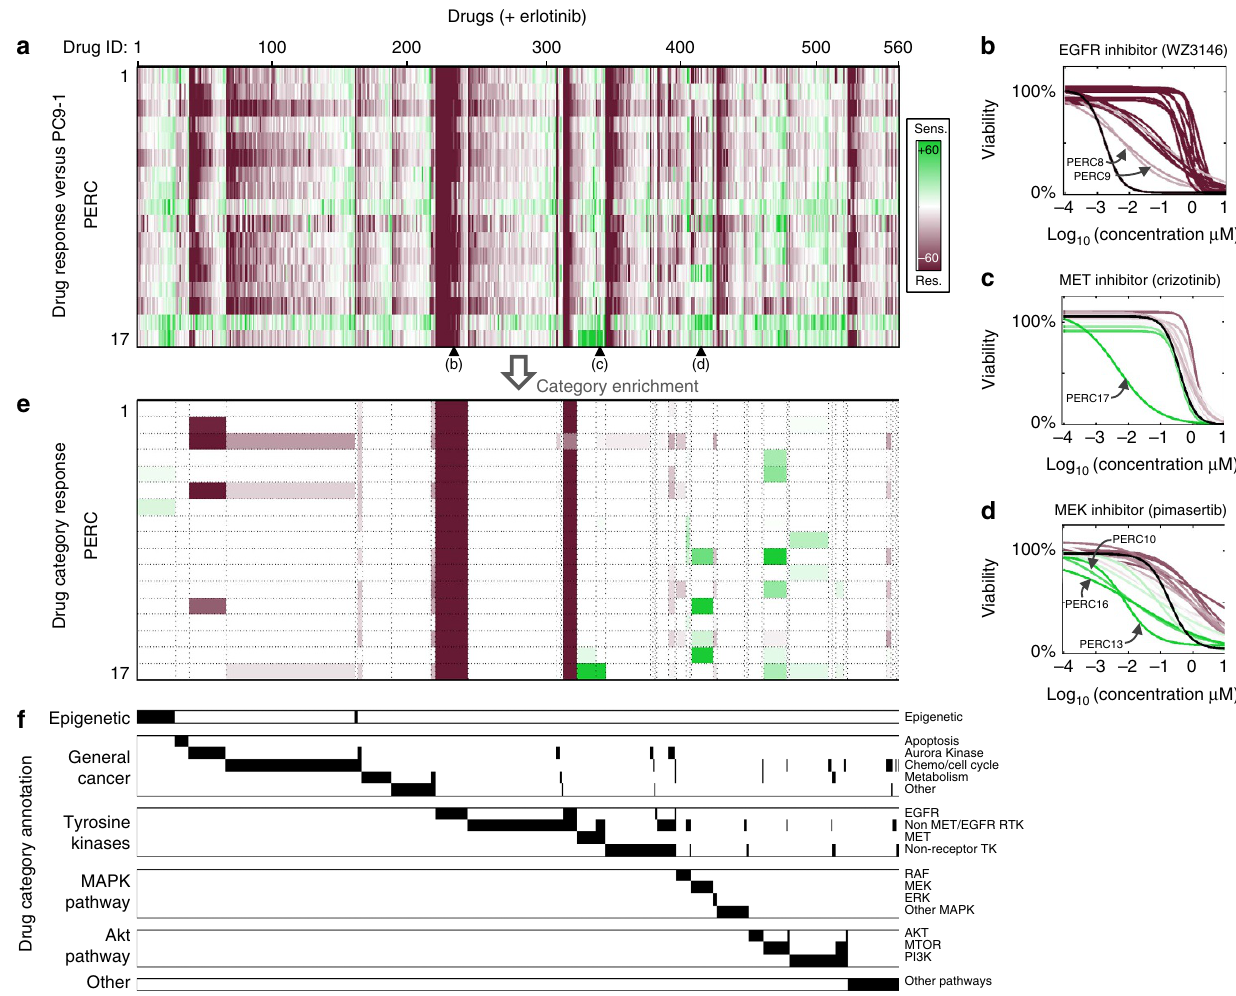
Figure 2 | Identification of PERC drug-resistance mechanisms via drug screening for therapeutic vulnerabilities. Response of PERCs versus PC9-1 to a diverse drug library. ( a ) Heatmap: drug-response scores of the PERCs (screen performed in erlotinib-containing media) relative to PC9-1 (screen performed in drug-free media). Rows: PERCs. Columns: 560 anticancer compounds. Scores (green/red colours): based on signed-area differences between drug-response curves of PERCs versus PC9-1 (Methods). Each response score reflects six doses performed in duplicate ( n ¼ 2). ( b – d ) Shown are smoothed response curves with respect to selected drugs (corresponding to black triangles in a ). Graphs: PERCs (drug þ 2.5 m M erlotinib; response curves coloured according to scores) versus PC9-1 (only drug no erlotinib; black). Green/red: drug-response scores of PERC compared with PC9-1. Smoothed curves were constructed by fitting the mean viability ( n ¼ 2) at each dose to a sigmoidal function using an unweighted least-squares fit (Methods). ( e ) Heatmap: enrichment of PERCs (rows) for strong response to specific drug categories (columns). Drug-category-response scores are based on a hypergeometric test for varying drug-response scores (Methods; Supplementary Fig. 3). Green/red: colours as in a . ( f ) Annotation of drugs (columns) to specific drug categories